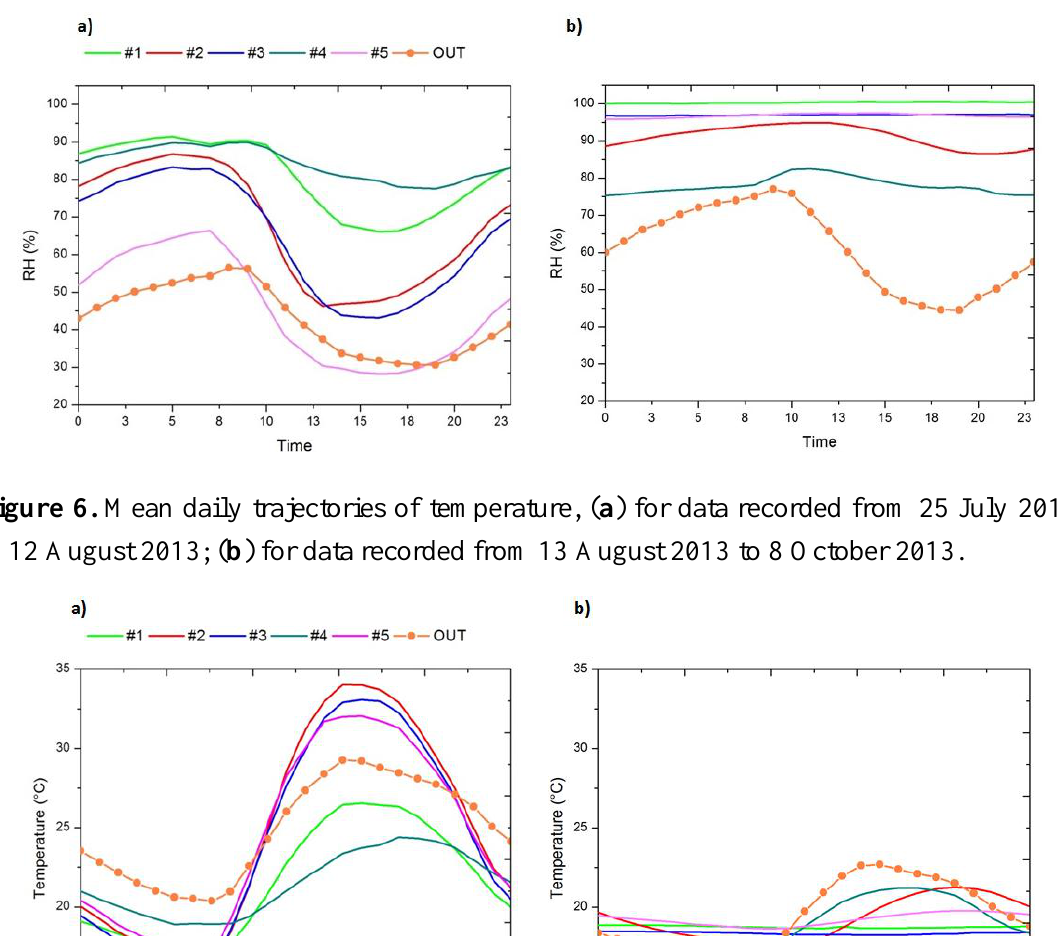
Figure 5. Mean daily trajectories of relative humidity, ( a ) for data recorded from 25 July 2013 to 12 August 2013; ( b ) for data recorded from 13 August 2013 to 8 October 2013.